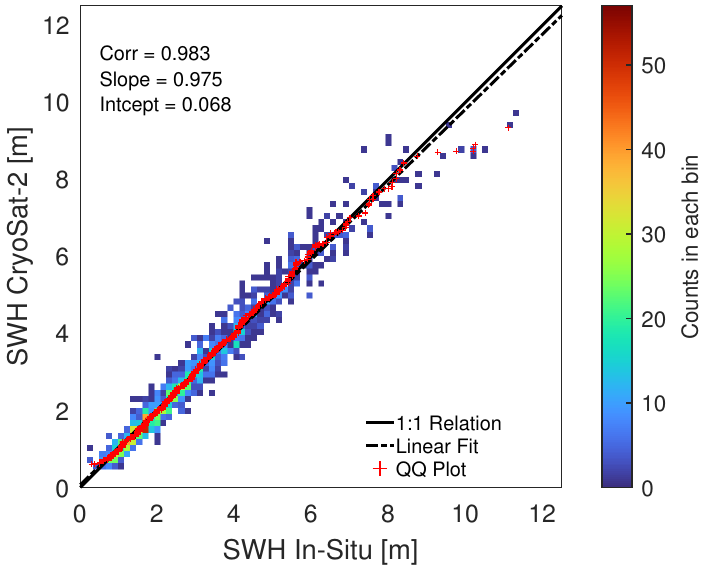
Figure 2. Comparison of CryoSat-2 significant wave height (SWH) observations and in situ stations to show any bias or change in the altimeter measurements compared to the true measured data. Using 2124 observations, a mean difference of − 0.009 m and an root mean squared error (RMSE) of 0.308 m were